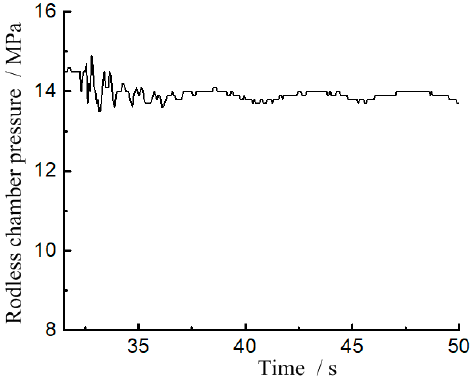
Figure 11. Curves of rodless chamber pressure at 400 r /